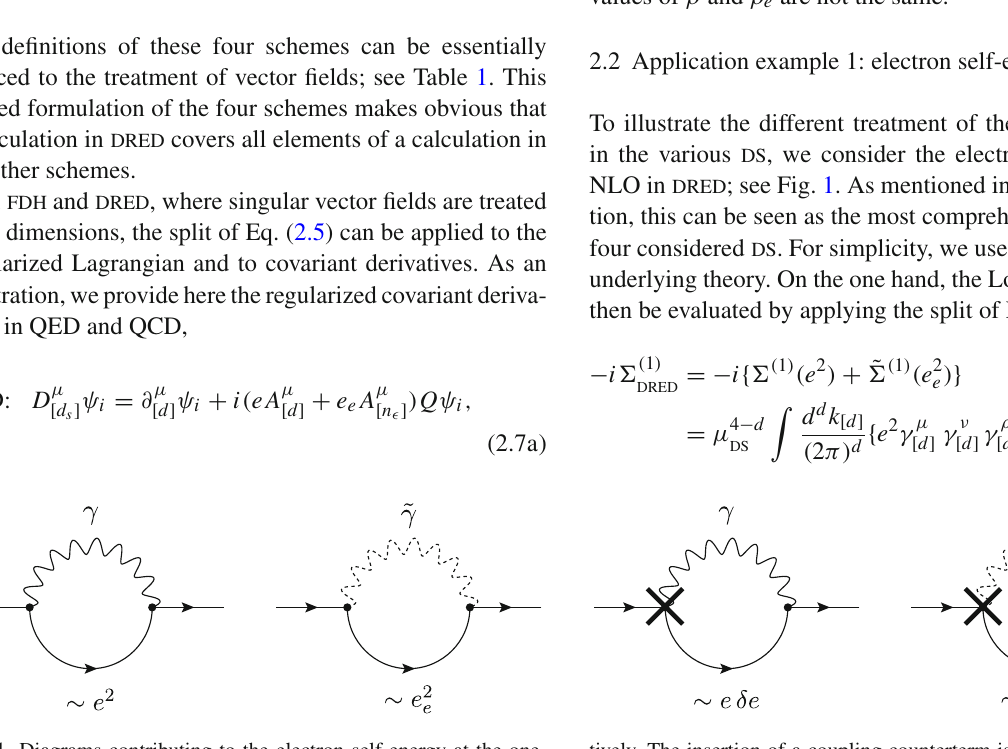
tively. The insertion of a coupling counterterm is denoted by a cross . The (cid:3) -scalar diagrams only exist in fdh and